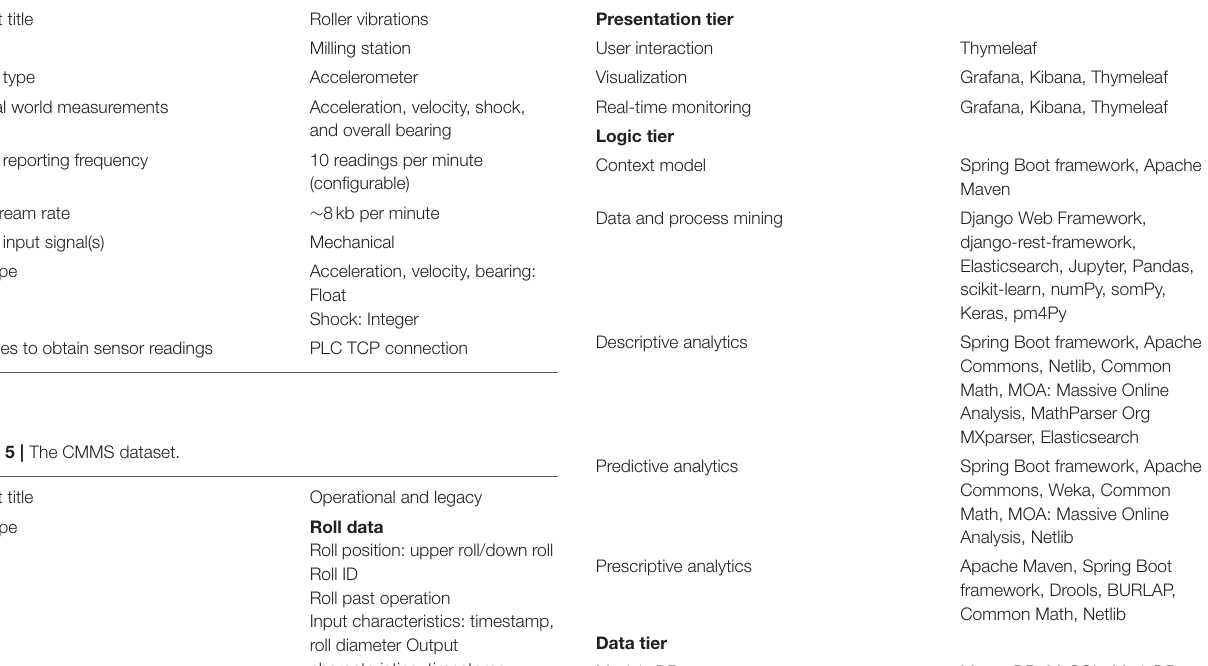
TABLE 4 | Summary of the streaming dataset.